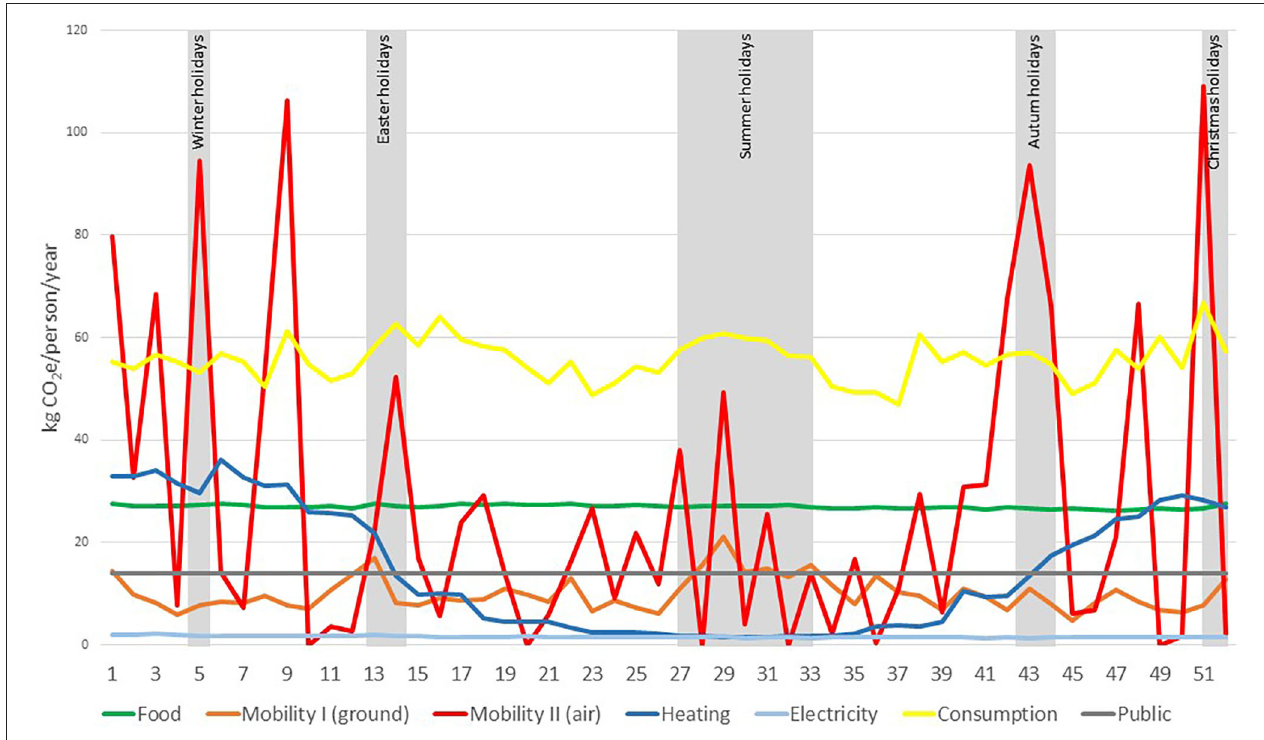
FIGURE 2 | Annual development of KliB households 2018 in kg CO 2 per person. Source: Own Data.